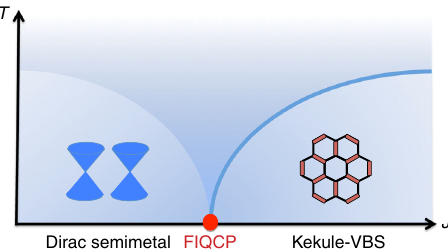
Fig. 1 The fermion-induced quantum critical point (FIQCP). According to the Landau cubic criterion, the transition would be putatively fi rst-order because cubic terms of order parameters are allowed by symmetry in the Landau – Ginzburg theory. However, it can be induced to be second order by coupling to massless Dirac fermions. This FIQCP provides a new